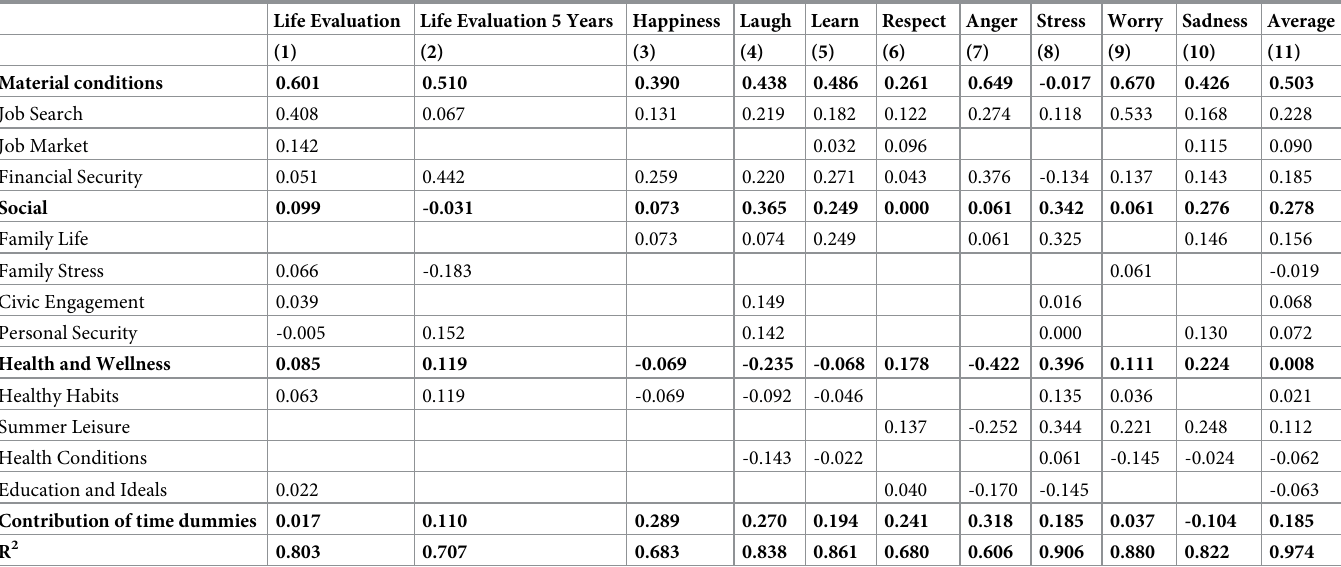
Table 5. Decomposition of the explained variance of subjective well-being